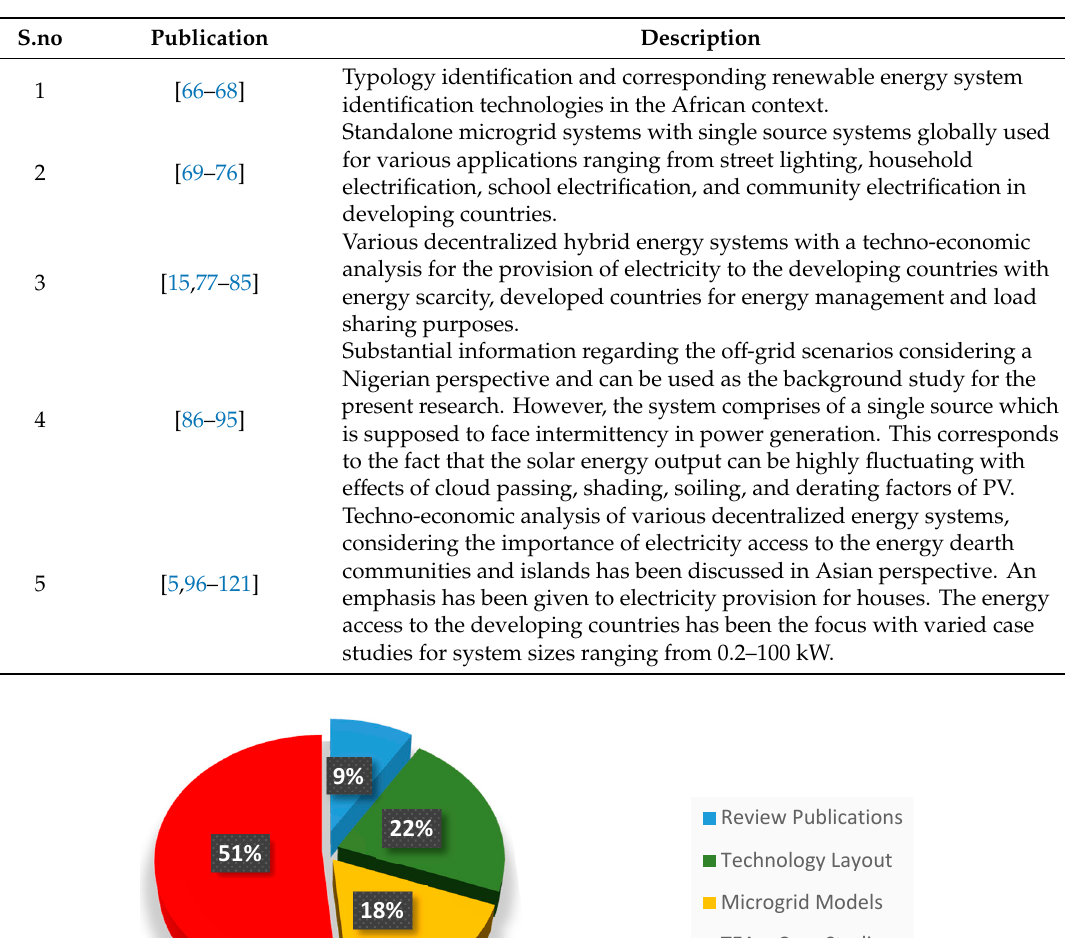
Table 4. Microgrid techno-economic analysis (TEA) and case studies for o ff -grid systems (standalone and hybrid).